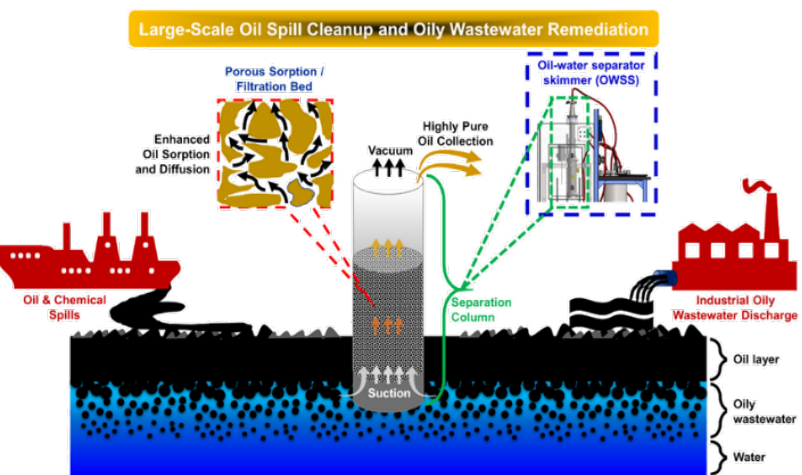
Figure 13. Schematic of the integrated process for O/W emulsions treatment [193]. Reproduced with permission from Z.N. Pintarič, et al., 2016 (ref. [ 193]). Copyright 2016, Higher Education Press and Springer-Verlag Berlin Heidelberg.